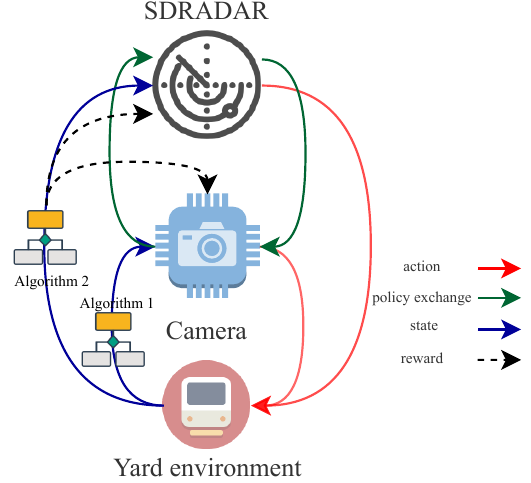
Figure 7. Calibration and multi-sensor reinforcement